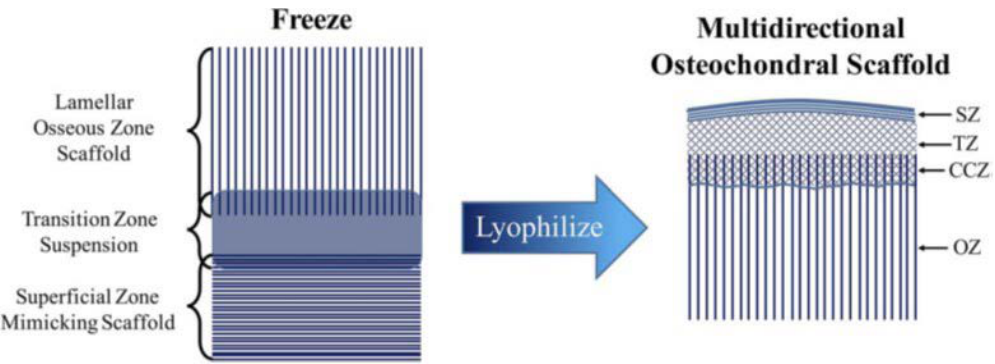
Figure 5. Diagram of the lyophilisation process used to fabricate the final osteochondral scaffold. Scaffold contains superficial (SZ), transition (TZ), calcified cartilage (CCZ), and osseous zones (OZ). Adapted with permission from ref [42]. Copyright 2011 by John Wiley & Sons, Inc.